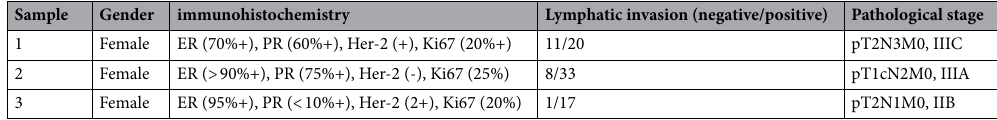
Table 1. Pathological and immunohistochemistry information of the 3 pairs of